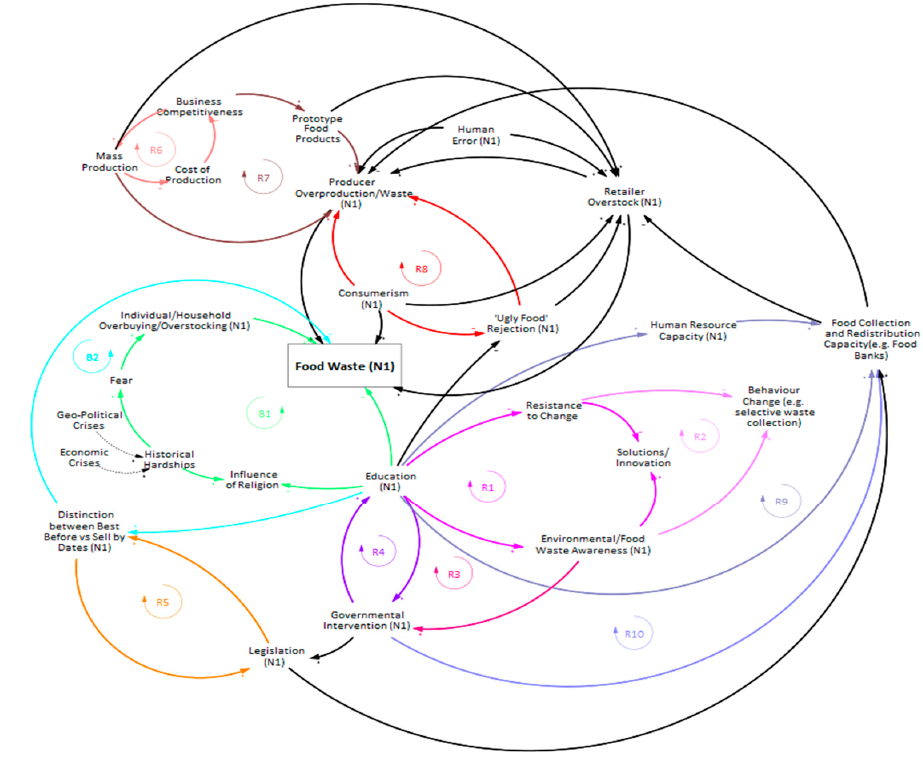
Figure A3. Food waste loop diagram elaborated during modeling session with the representative of NGO 1 (each color highlights a distinct loop).